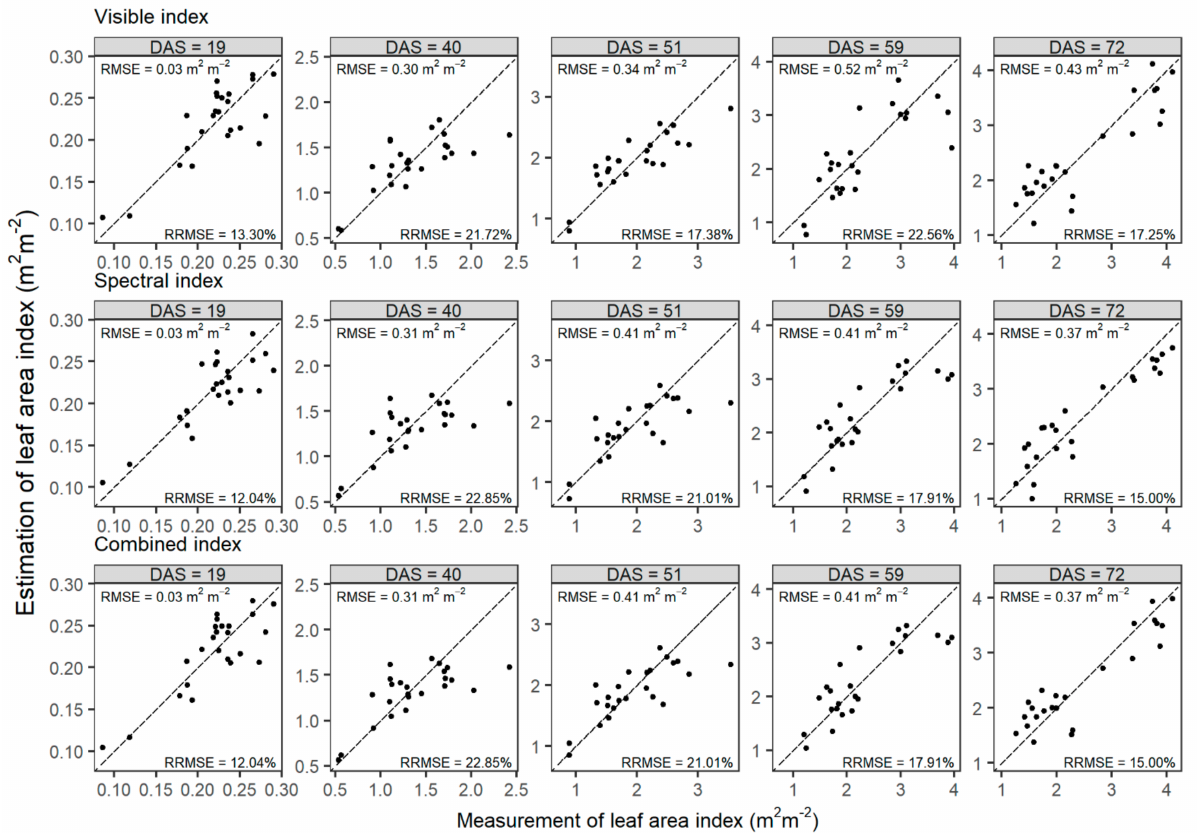
Figure 8. Comparisons of measurements and estimates of leaf area index of wheat in the testing set at five prediction dates (represented by days after sowing, DAS) before flowering. Leaf area index was estimated by PLSR models, which were developed using the mono-temporal datasets of visible, spectral, and combined indexes at prediction dates, respectively. Dashed lines are one-to-one